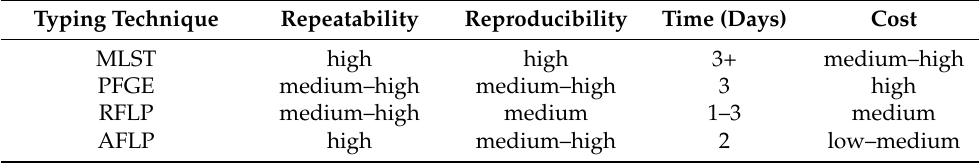
Table 2. Comparison of common typing techniques in relation to accuracy, time, and